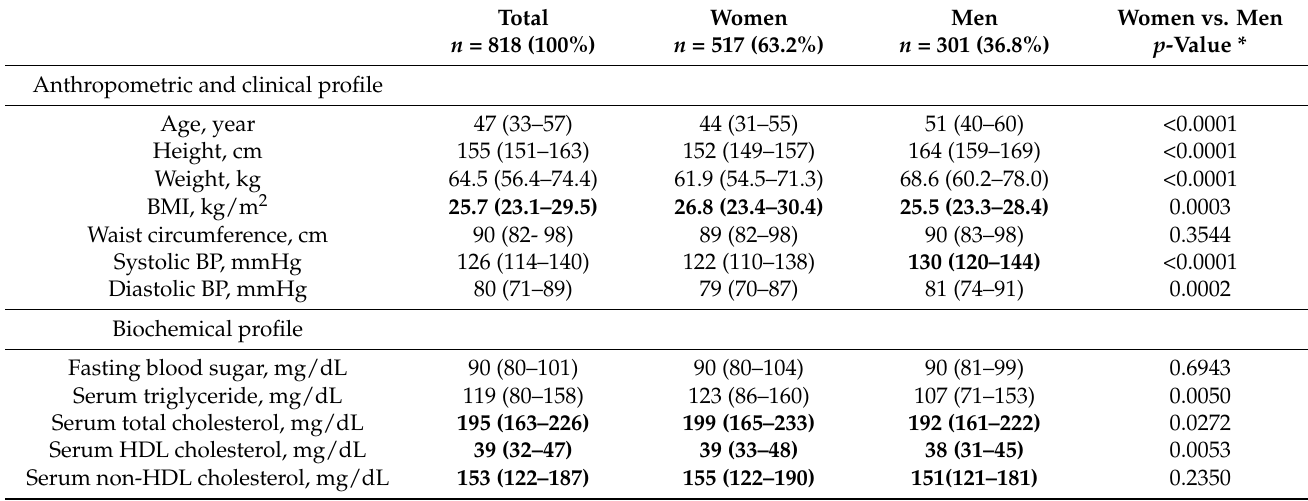
Table 1. Anthropometric, clinical, and biochemical profiles of the participants. Data are presented as median and in- terquartile ranges. Median values out of the acceptable range recommended by the Brazilian Guidelines are highlighted in